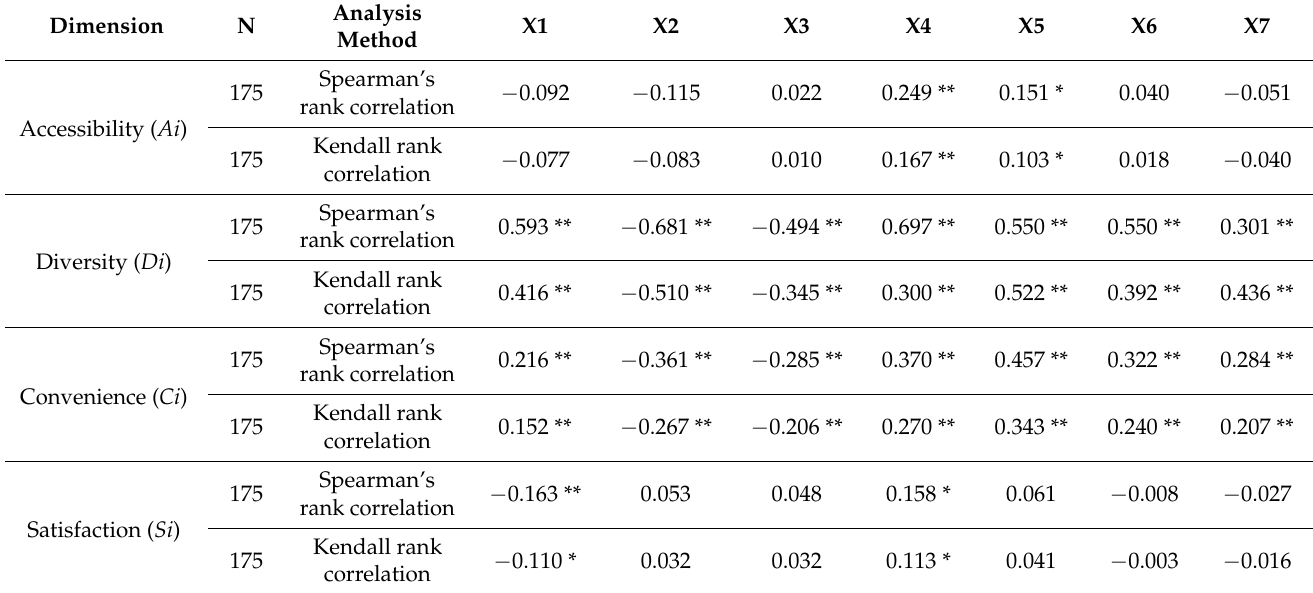
Table 9. Correlations between the four dimensions and community properties.